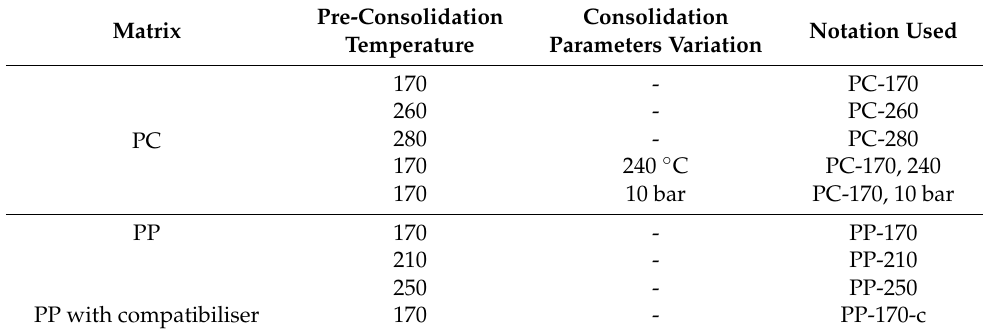
Table 3. BF continuous fibre composites in this paper.